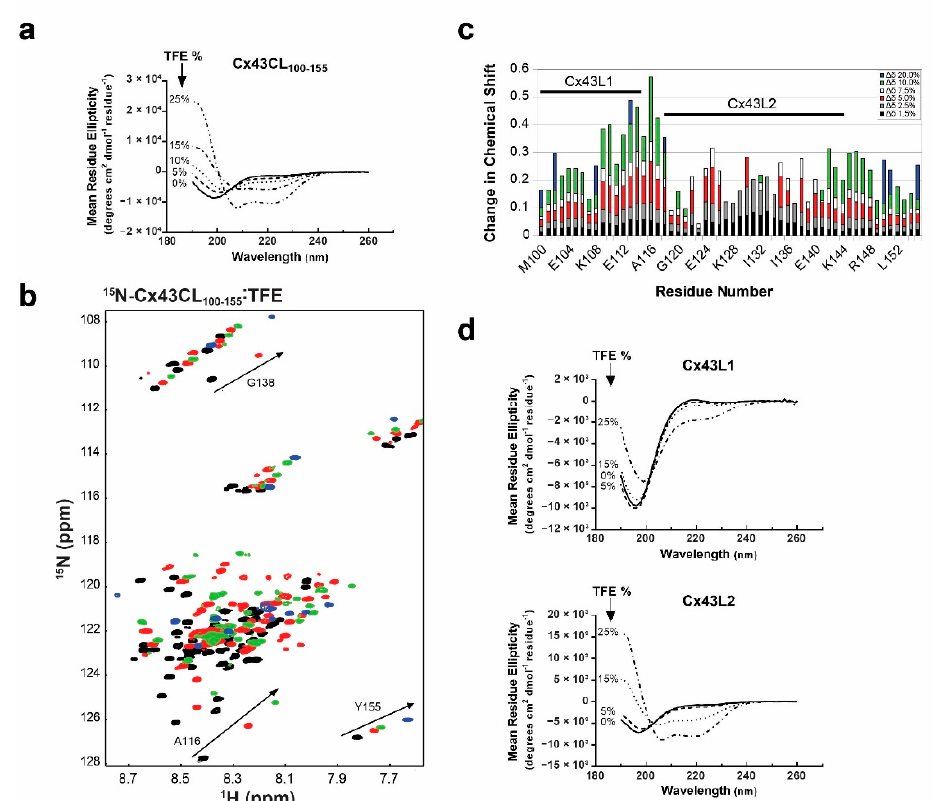
Figure 2. Propensity of the Cx43CL 100-155 domain to form α -helical structure. ( a ) CD spectra of Cx43CL 100-155 in the presence of increasing amount of trifluoroethanol (TFE) (percentages indicated on the left side of the curves). ( b ) 15 N-HSQC spectrum of 15 N-labeled Cx43CL 100-155 only (black) has been overlaid with spectra obtained when increasing amount of TFE were added (5%, red; 10%, green; and 20%, blue). Spectra for the Cx43CL 100-155 in the presence of 1.5%, 2.5%, and 7.5% of TFE were also collected and used for the measurement of the change in chemical shifts (panel c ) but not shown because of the overlap of the peaks. ( c ) Each Cx43CL 100-155 residue was plotted against their change in chemical shift as a function of TFE concentration. The two major affected areas have been labeled and a representative residue for each area is displayed in panel b (A116 for Cx43L1, G138 for Cx43L2, and Y155 for the area outside of L1 and L2). ( d ) CD spectra of Cx43L1 residues M100-A116 (top panel) and Cx43L2 residues D119-K144 (bottom panel) were collected in 1x PBS at pH 5.8 in the absence and presence of varying concentrations of TFE (percentages displayed in each panel).